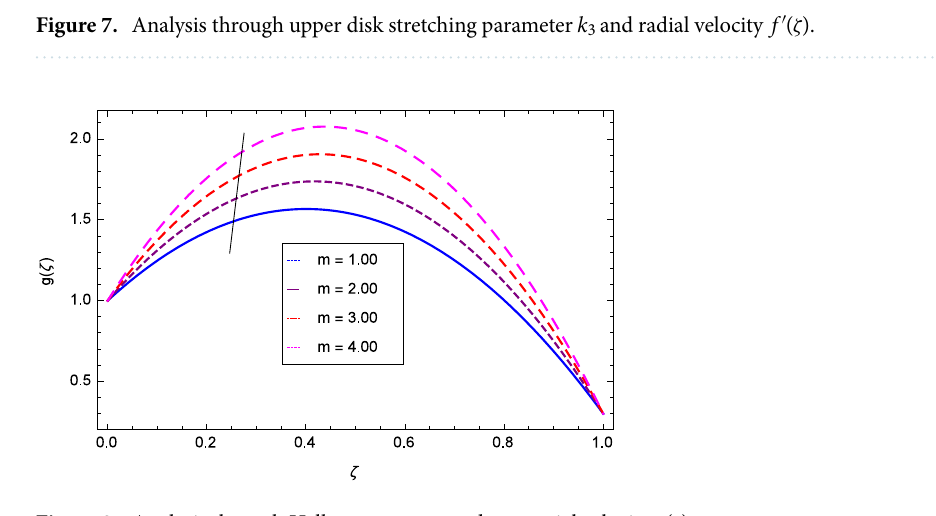
Figure 19 considers the nanoparticles concentration profile ϕ ( ζ )